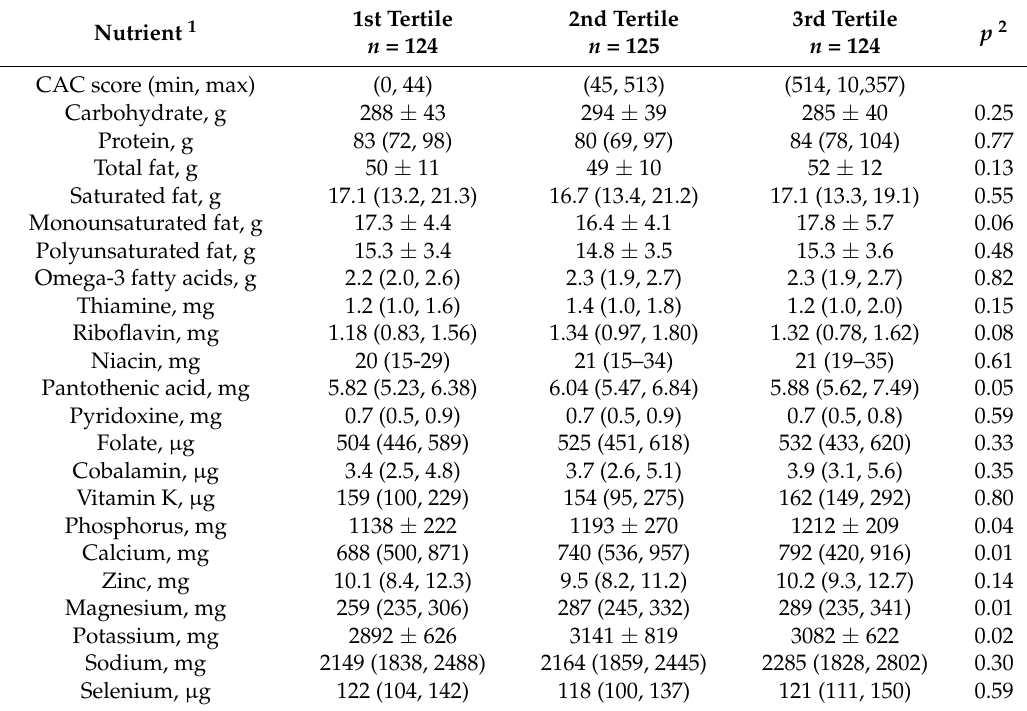
Table 2. Nutrient intakes of participants included in the study according to tertiles of